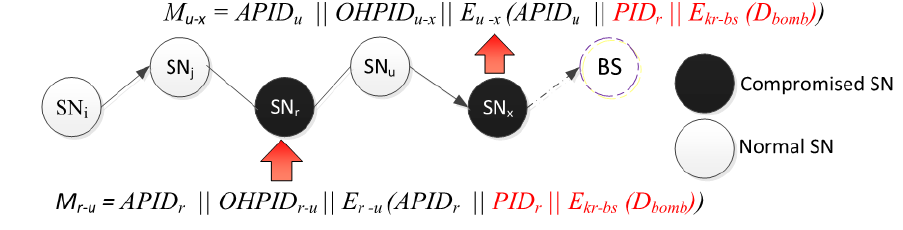
Figure 19. Hard-active Attack tries to get the BS by inserting a signature in the transmitted message.